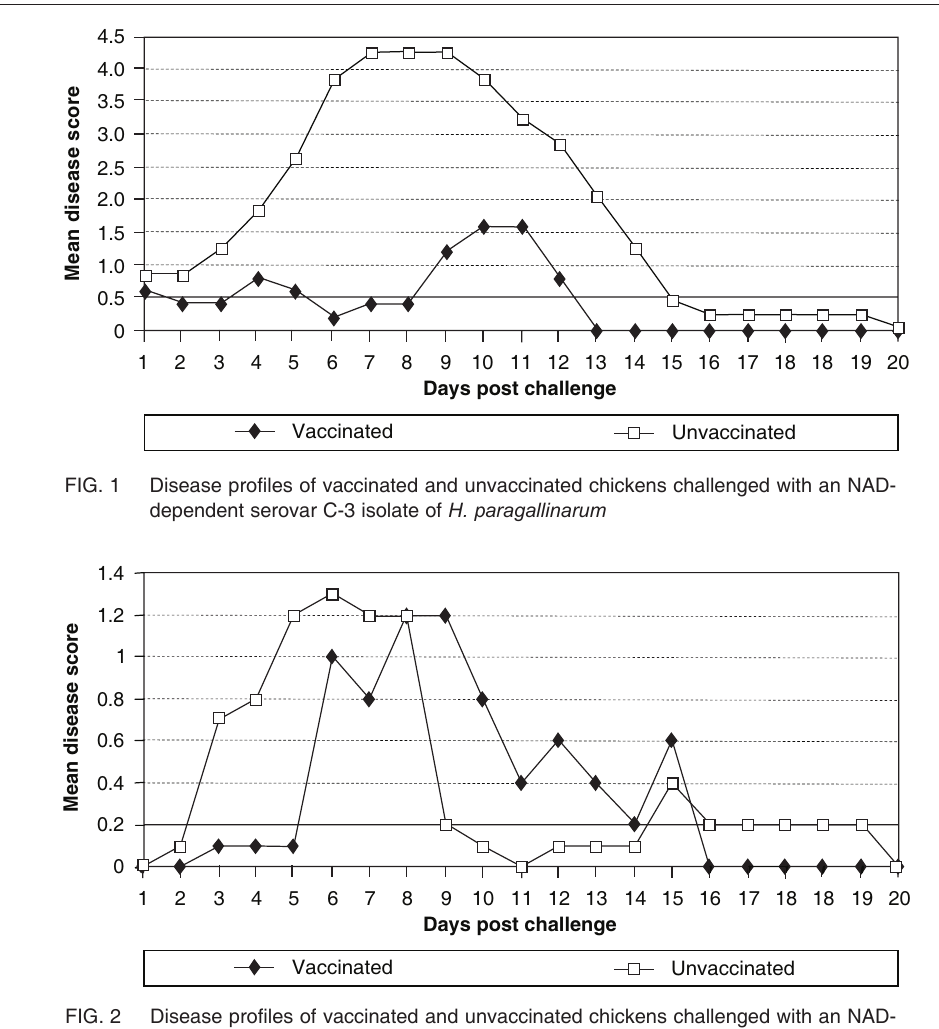
vaccinated chickens are similar. It was found that there is not a significant difference between the two profiles ( P = 0.389). It is evident from the graph in Fig. 2 that the development of clinical signs in the vaccinated birds was delayed when compared to that of unvaccinated birds and that the duration of clinical signs was shorter in the vaccinated birds. However, the highest daily disease scores of the two groups of birds were found to be very similar (Table 1). This is in contrast to the results obtained when the birds were challenged with the NAD- dependent isolates. The data obtained revealed that there is a significant difference ( P = 0.000358) between the disease profiles obtained for the vac- cinated and unvaccinated birds. These results indi- cate that the vaccine used in this experiment pro- vided protection when the birds were challenged with the NAD-dependent serovar C-3 isolate.